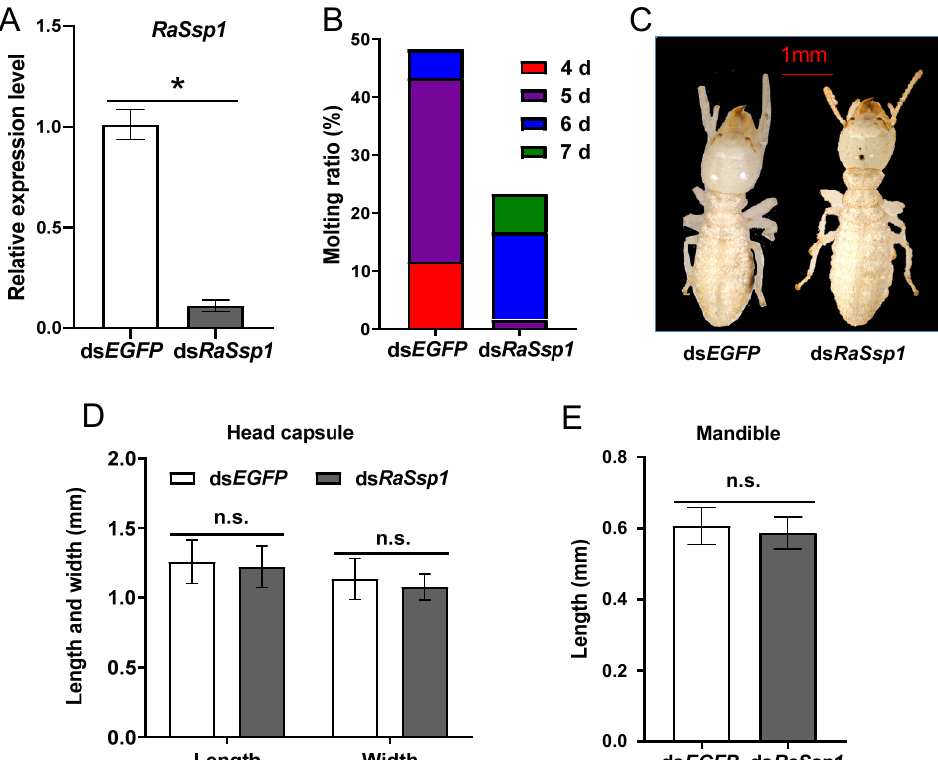
Figure 3. Effect of worker RaSsp1 RNAi on presoldier differentiation. RaSsp1 dsRNA was injected at the beginning of the gut-purging period in workers, with EGFP dsRNA as control. ( A ) Expression levels of RaSsp1 in the head of workers on the 3rd day after injection of dsRNA RaSsp1 (mean ± S.D., technical triplicates). ( B ) Effect of the 1st molting ratio after Rassp1 RNAi; 4, 5, 6 and 7 d are the 4th, 5th, 6th and 7th days after injection dsRNA (n = 60). ( C ) Presoldier morphology affected by dsRNA injection. Both presoldiers were photographed on the 2nd day after the 1st molt. Scale bar indicates 1 mm. The photos represent the 16 presoldiers. ( D ) The length and width of the head capsule (mean ± S.D., n = 16). ( E ) The left mandible length. Asterisks indicate a significant difference; n.s. means not significant (one-way ANOVA followed by LSD test using SPSS, p < 0.05).